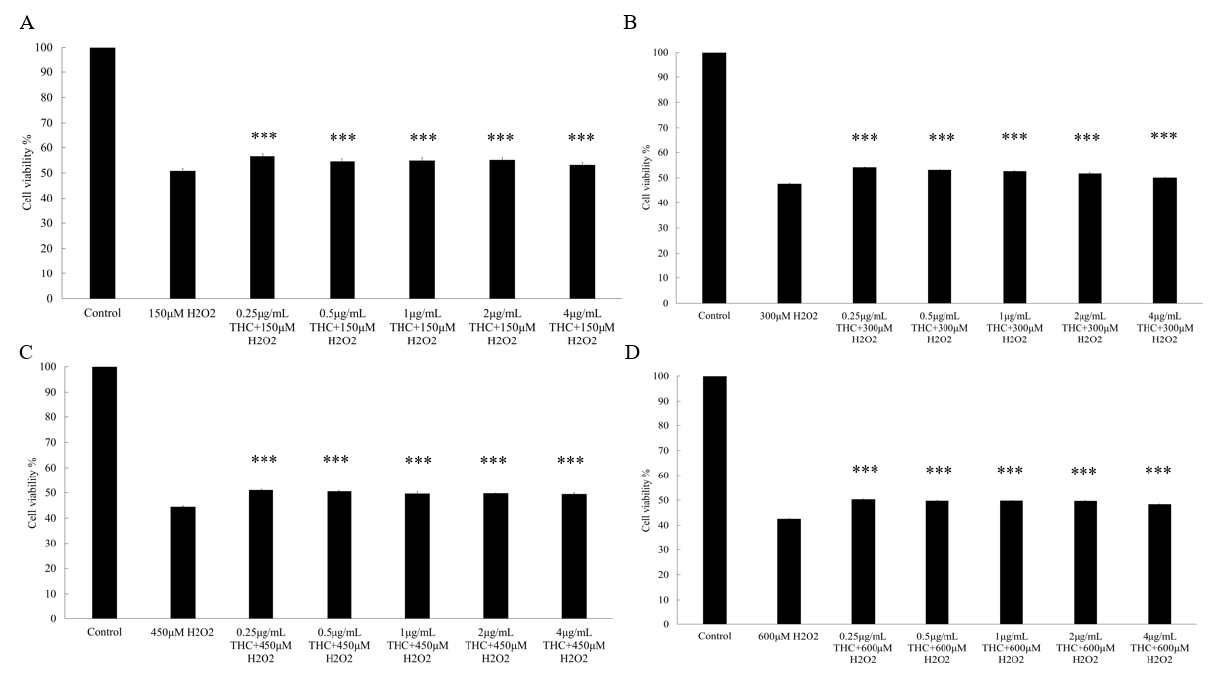
Figure 2. Effect of various tetrahydrocurcumin (free of THC as the control group, 0.5, 1, 2, and 4 µg/mL) concentrations and each individual H 2 O 2 concentration (150 ( A ), 300 ( B ), 450 ( C ), and 600 ( D ) µM) on the viability of HaCaT cells after 24 h. Results are expressed as mean SD ( n = 3). *** p < 0.001 compared to the cells treated with H 2 O 2 only in each group.